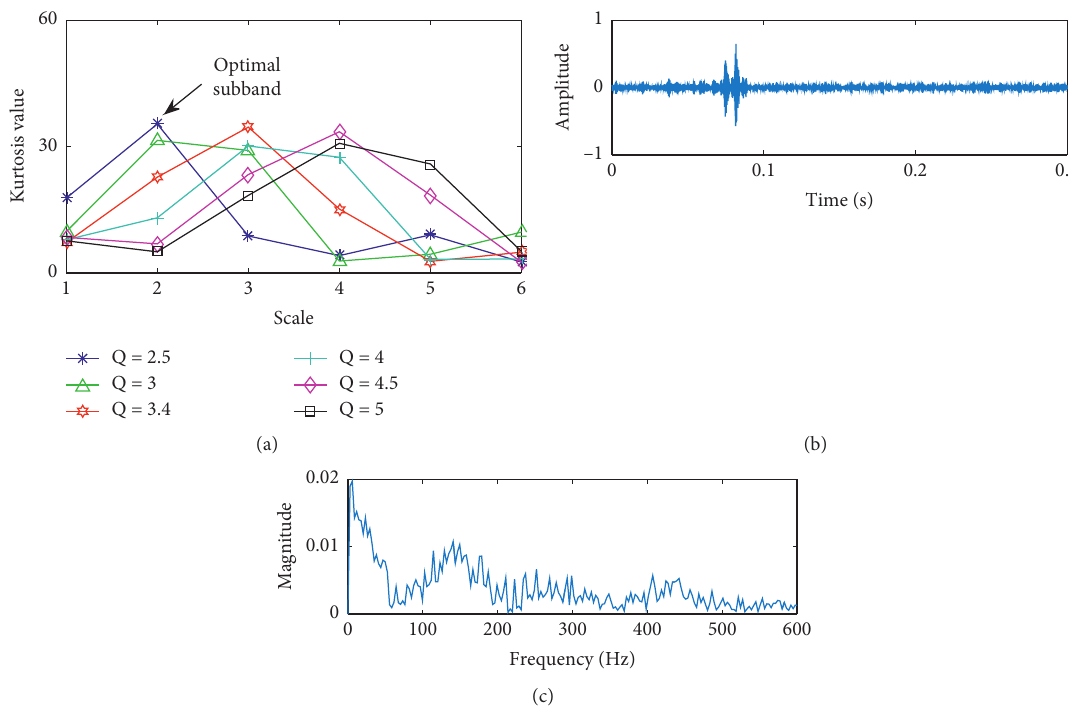
Figure 12: (a) Optimal subband selection process of the kurtosis-guided TQWT method, (b) time-domain waveform of the optimal subband, and (c) envelope spectrum of